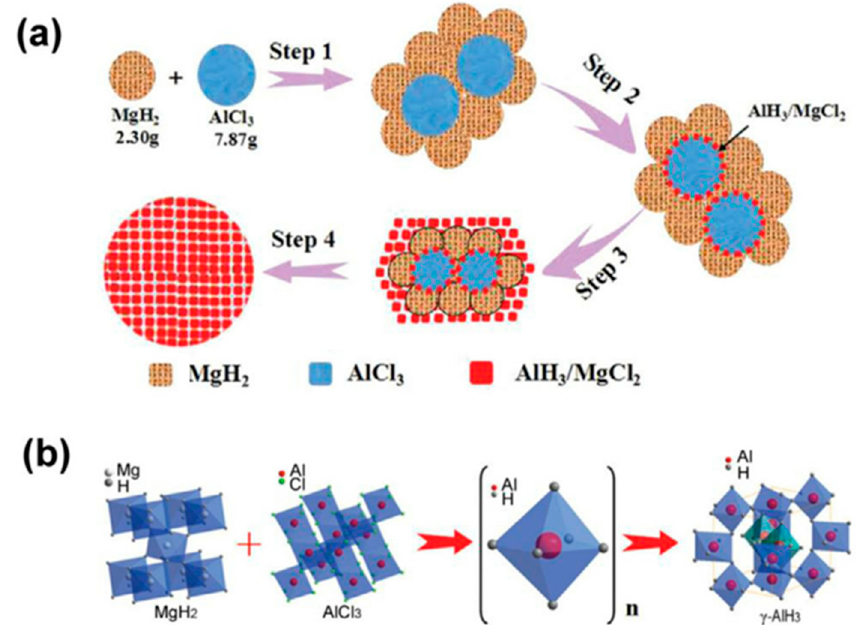
Figure 7. ( a ) The pathway of the mechanically activated reaction between MgH 2 and AlCl 3 . ( b ) Mechanism of the solid state synthesis of nano-sized γ − AlH 3 . Reprinted with permission from Ref. [56]. Copyright 2021